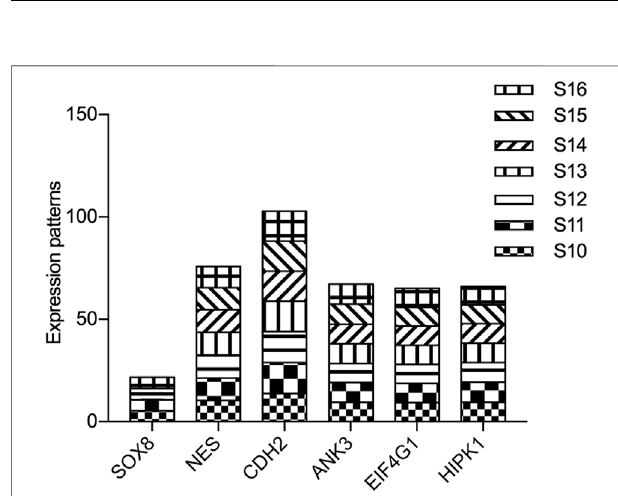
FIGURE 9 | The speci fi c amino acid sites of variants of our candidate gene. The red balls represent the location of rare variant on the encoded proteins or protein domains.